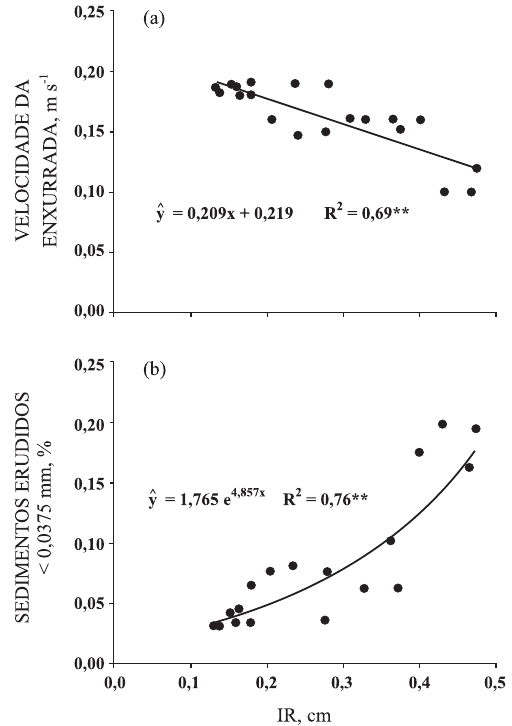
Figura 5. Relação da velocidade da enxurrada (a) e do percentual (base de massa) dos sedimentos erodidos com tamanho < 0,0375 mm (b), ambos avaliados na condição de equilíbrio da enxurrada, com o índice IR da rugosidade superficial do solo criada pelo